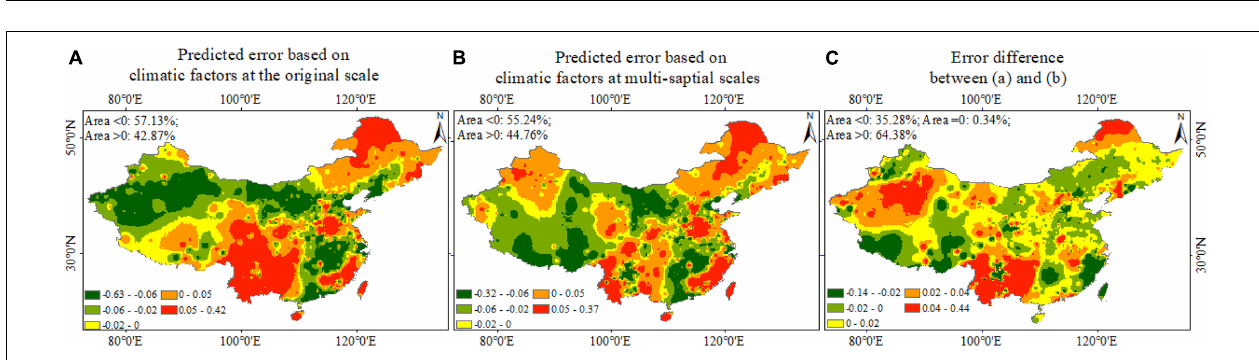
FIGURE 7 | Spatial distribution of local correlation coefficients between mean annual-maximum NDVI and mean annual climatic factors at different spatial scales, including (A) original scale, (B) 2.09 × 10 4 km 2 scale, and (C) > 9.56 × 10 4 km 2 scale. NDVI, normalized difference vegetation index.